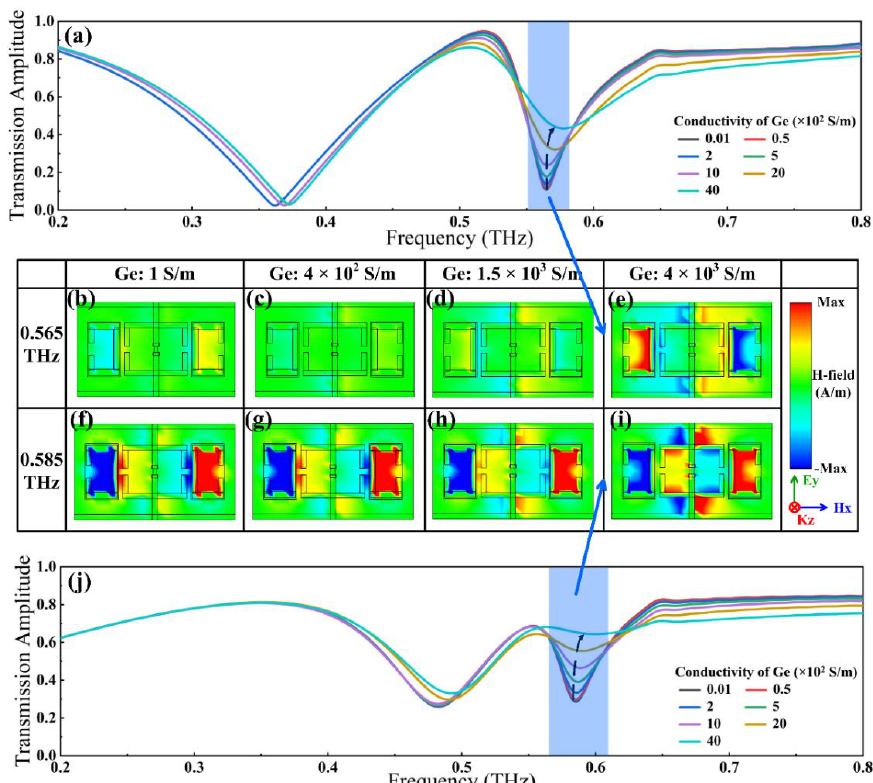
Figure 5. Characterizations of the hybrid metasurface modulated by the optical method. ( a , j ) Transmission spectra depending on Ge layer conductivity when conductivity of VO 2 bridges is fixed at ( a ) 2 × 10 2 S/m and ( j ) 2 × 10 5 S/m. ( b – e ) Distributions of the H-field transmitted through the surface with the increase in Ge layer conductivity at 0.565 THz when fixing VO 2 bridges at 2 × 10 2 S/m. ( f – i ) Distributions of the H-field transmitted through the surface with the increase in Ge layer conduc- tivity at 0.585 THz when fixing VO 2 bridges at 2 × 10 5 S/m.